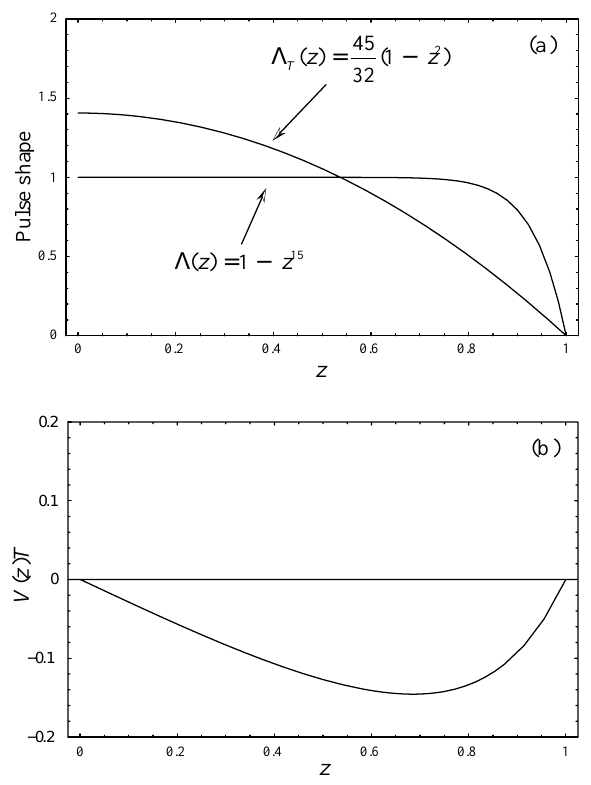
FIG. 4. Initial pulse shape L (cid:2) z (cid:3) (cid:1) 1 2 z 15 and final pulse shape L T (cid:2) z (cid:3) (cid:1) (cid:2) 45 (cid:1) 32 (cid:3) (cid:2) 1 2 z 2 (cid:3) are plotted in (a). The initial velocity V (cid:2) z (cid:3) given by Eqs. (56) and (52) is plotted in (b).